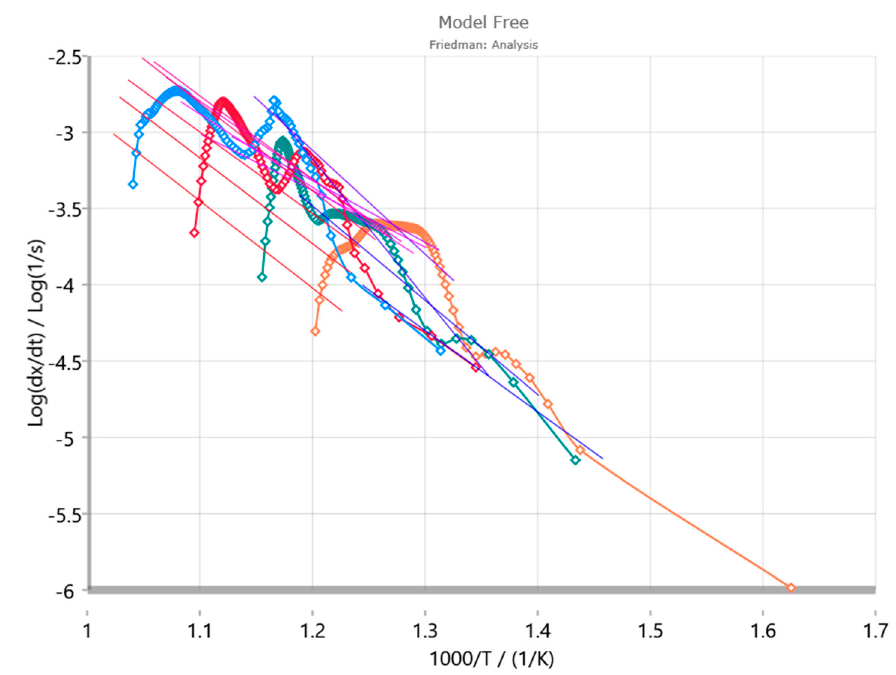
Figure 14. Friedman analysis of PEEK using 4 different heating rates in air (orange: 1 K/min, green: 2 K/min, red: 5 K/min, blue: 10 K/min).